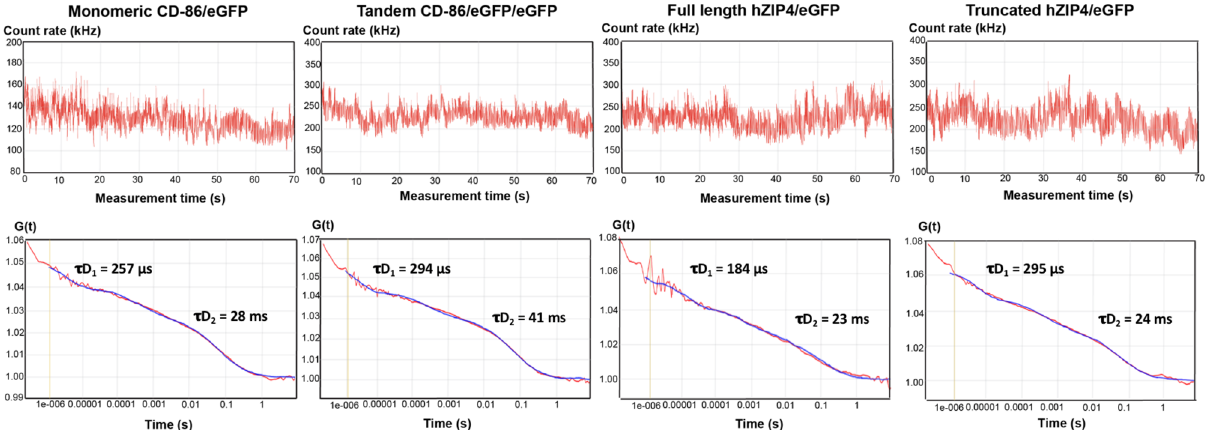
Figure 6. Fluorescence correlation spectroscopy (FCS) autocorrelation curves of eGFP-tagged membrane proteins. FCS recordings were made on the plasma membrane of transiently transfected HEK293 cells expressing the indicated eGFP-tagged proteins. CD-86/eGFP and CD-86/eGFP/eGFP are the monomeric and dimeric controls, respectively. Fluorescence intensity fluctuations from recording outside the range of 50–250 kHz were excluded. Autocorrelation curve of FCS data (red line) with a model curve fitting a two- dimensional two-component model.